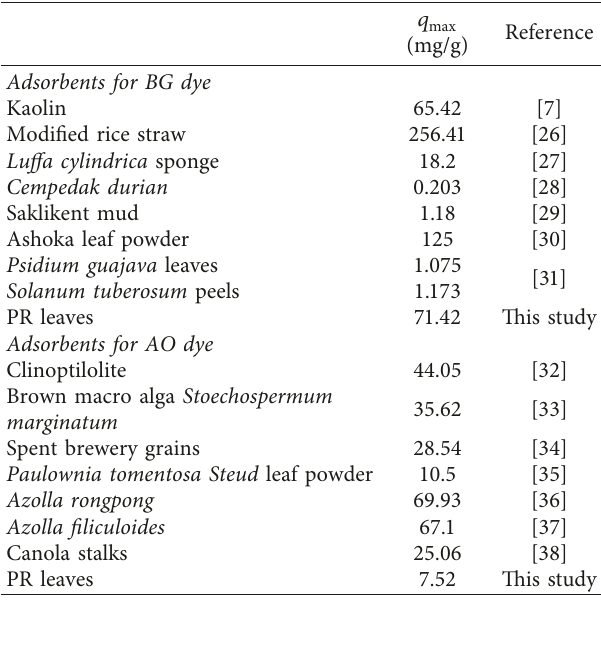
Table 4: Reported adsorbents and their removal capacity for BG and AO dyes.